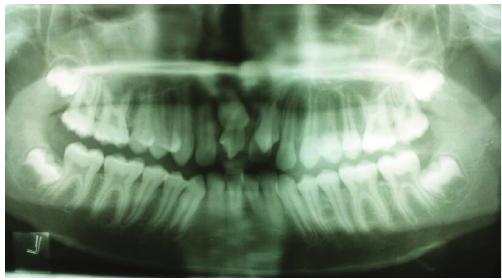
Figure 3: Panoramic view showing the two mesiodens in the anterior region of maxilla with unerupted left central incisor.